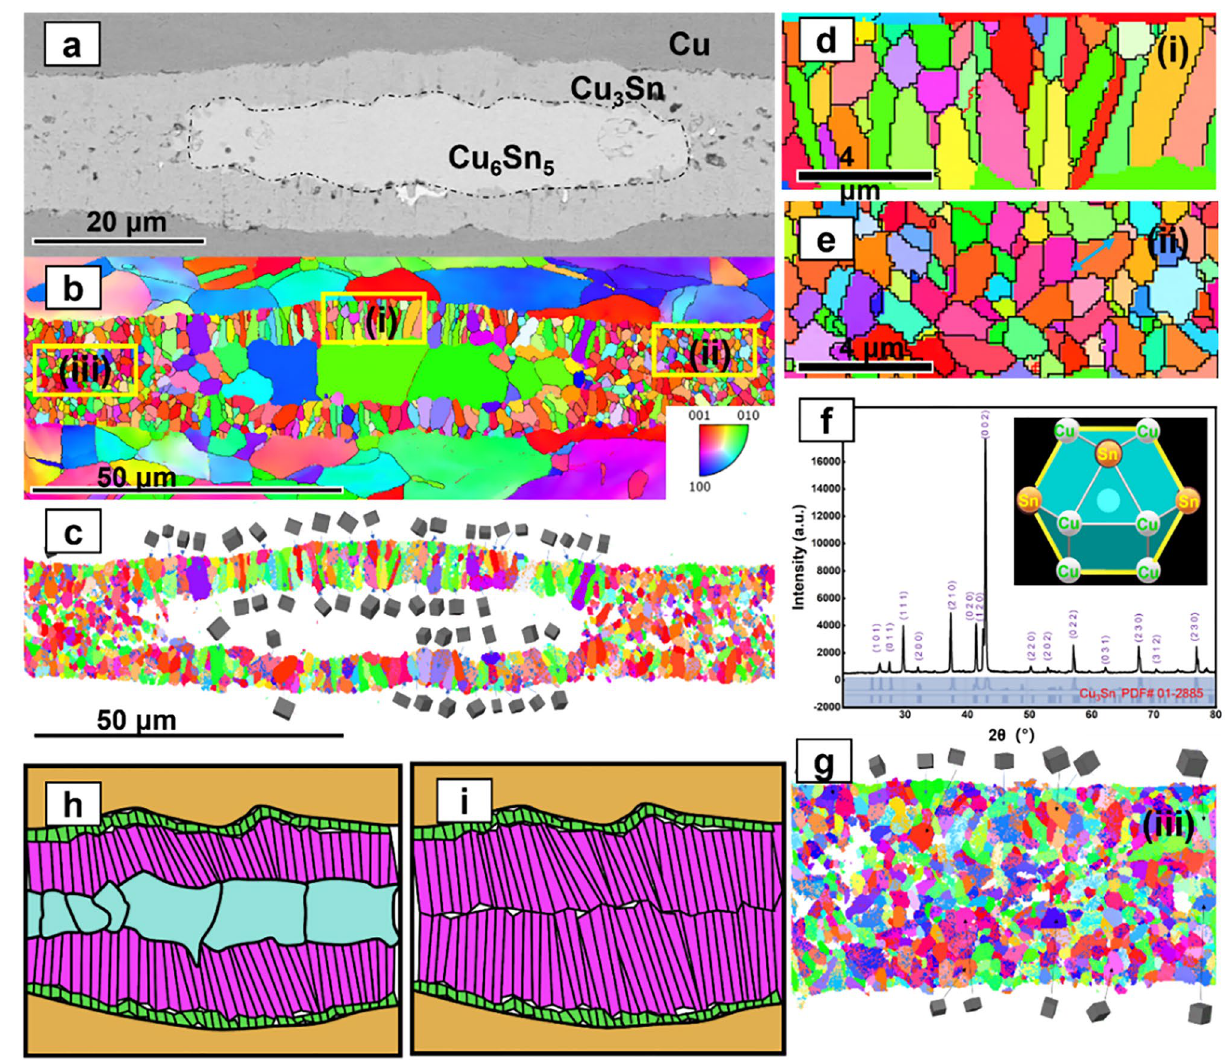
Figure 7. EBSD mapping of the joint (10 MPa auxiliary pressure, 30 min reflow at 280 ℃ ) ( a ) SEM image of joint reflowed 30 min at 280 ℃ , ( b ) EBSD mapping, ( c ) EBSD mapping, ( d ) EBSD mapping of columnar grains (location(i) in Fig. 7-b ), ( e ) EBSD mapping of equiaxed grains (location(ii) in Fig. 7-b ), ( f ) inverse pole figure. ( g ) EBSD mapping of location(iii) in Fig.